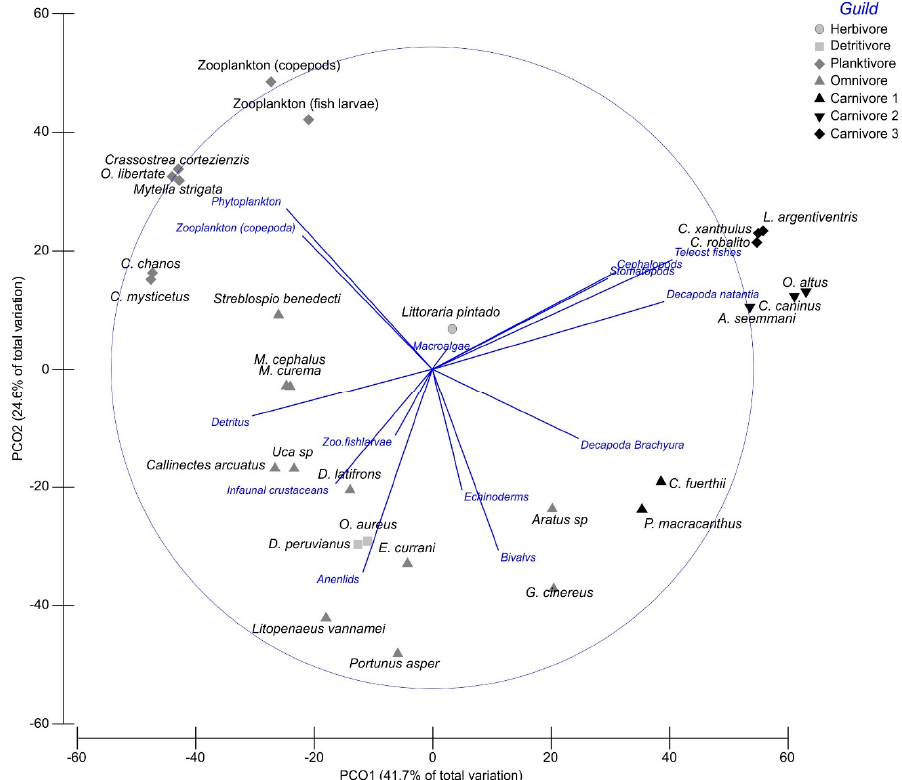
Figure 3. Principal coordinates analysis (PCO) showing the predators and their a priori designated feeding guild analyzed in the studied wetland. The vectors indicate the most important prey items for each group of predators.